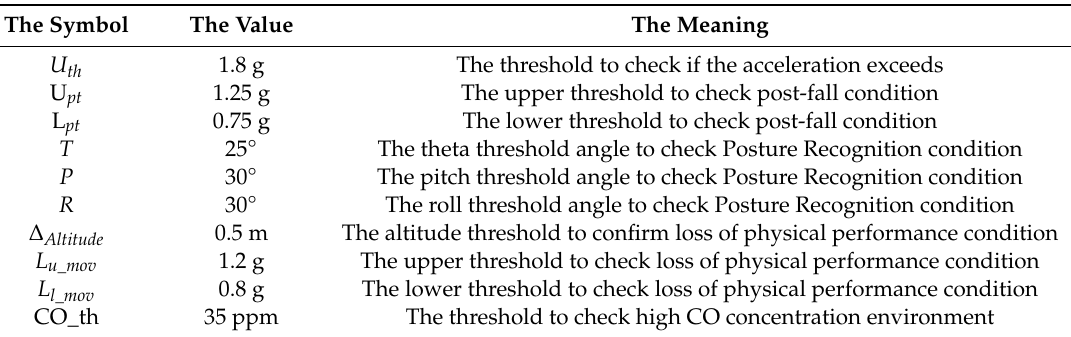
Table 5. The parameter setting.